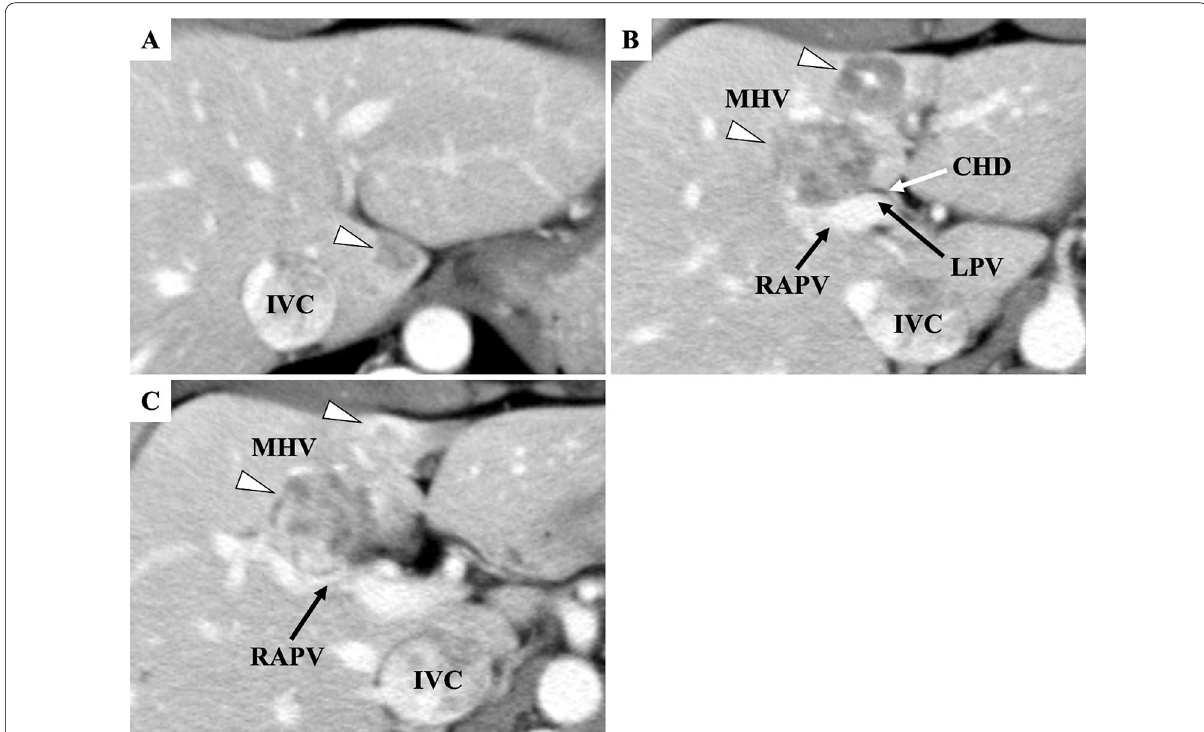
Fig. 1 Computed tomography shows hypervascular tumors of the liver in segment 1 ( A ) and segment 4 ( B ). IVC, inferior vena cava; MHV, middle hepatic vein; LPV, left portal vein; RAPV, right anterior portal vein; CHD, common hepatic